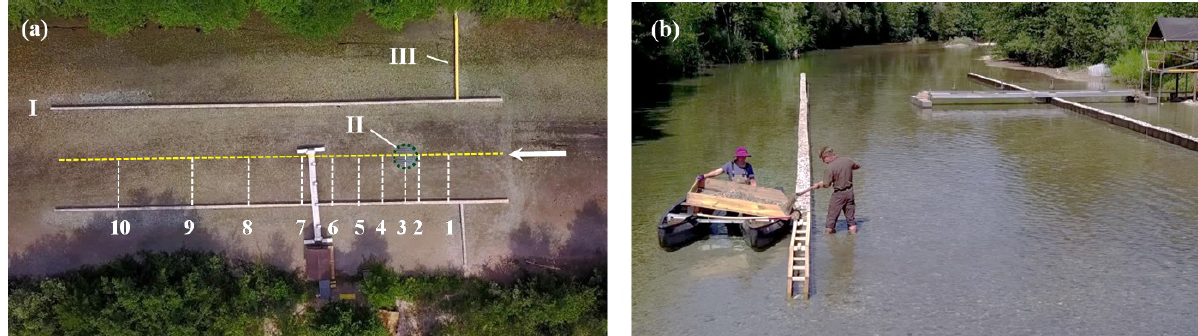
Figure 2. In-stream flume. (a) Aerial view of the flume (I is the wall of the flume, II is a model obstruction and III is a needle weir; the yellow dashed line is the longitudinal transect and white dashed lines are locations of lateral profiles in a typical layout of experimental run). (b) Construction of the in-stream